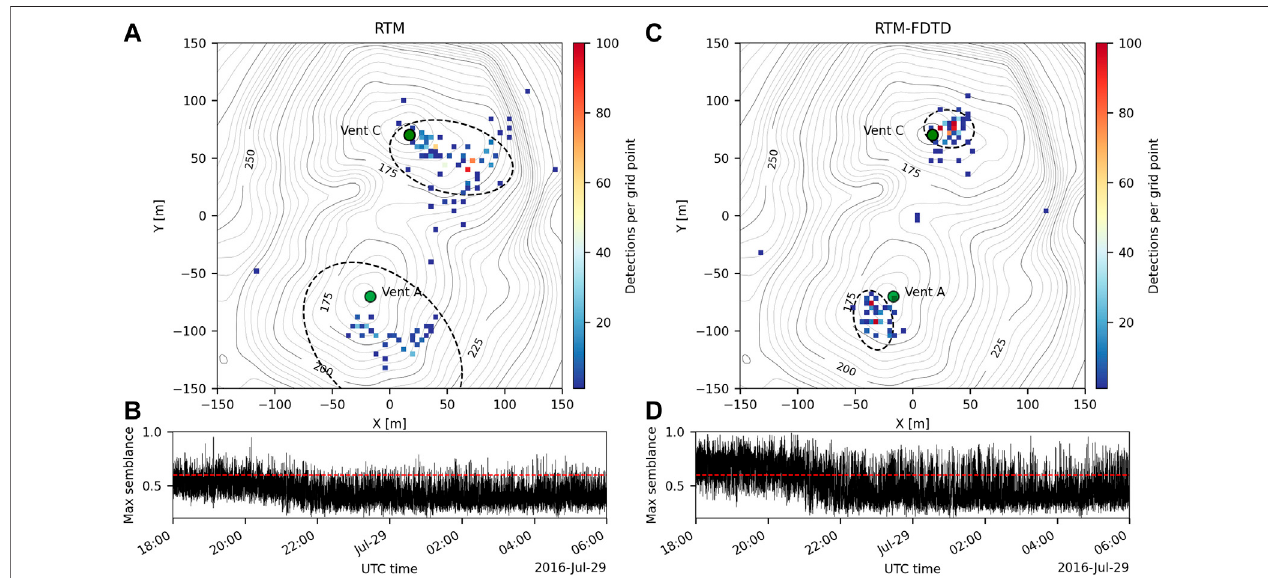
FIGURE 6 | Comparison of Yasur event detections and explosions over the 12 h shown in Figure 5 . RTM and RTM-FDTD semblance locations are shown as 2-D histogramsin (A) and (C) ,respectively,andthemaximumofthestackfunctionsin (B) and (D) .VentsAandCareindicatedbygreencirclesin (A) and (C) ,andthedashed ellipses represent 95% con fi dence ellipses. Red line in (B) and (D) indicates the detection threshold. RTM-FDTD detects more events and locates them closer to both vents in clear clusters, including over 400 events located at a single grid point near both Vent A and C. Con fi dence ellipses are much smaller for RTM-FDTD.